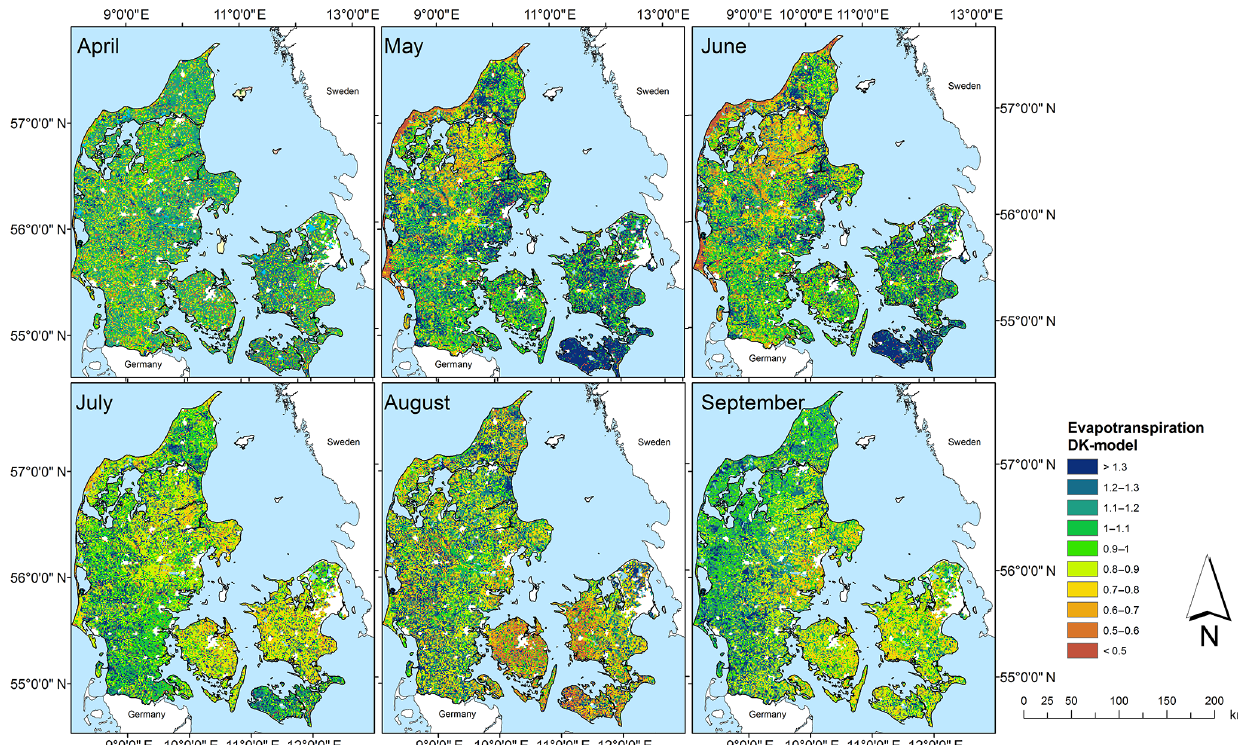
Figure 6. Monthly mean normalized DK-model ET maps (–) in which urban areas have been masked